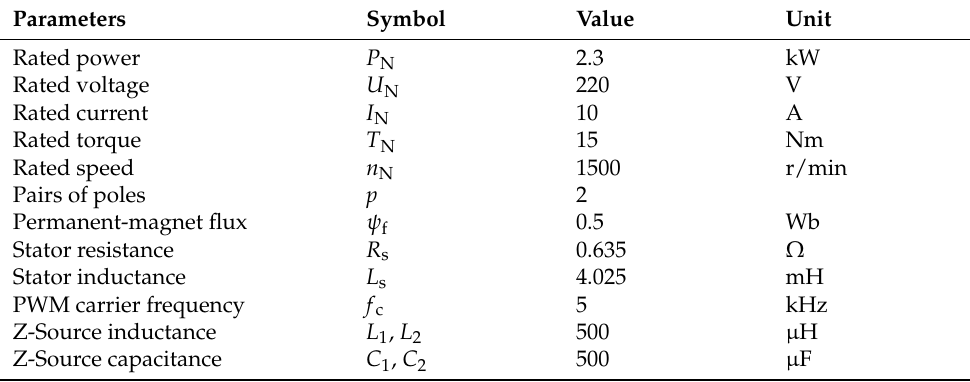
Table 1. Parameters of PMSM and QZSI.